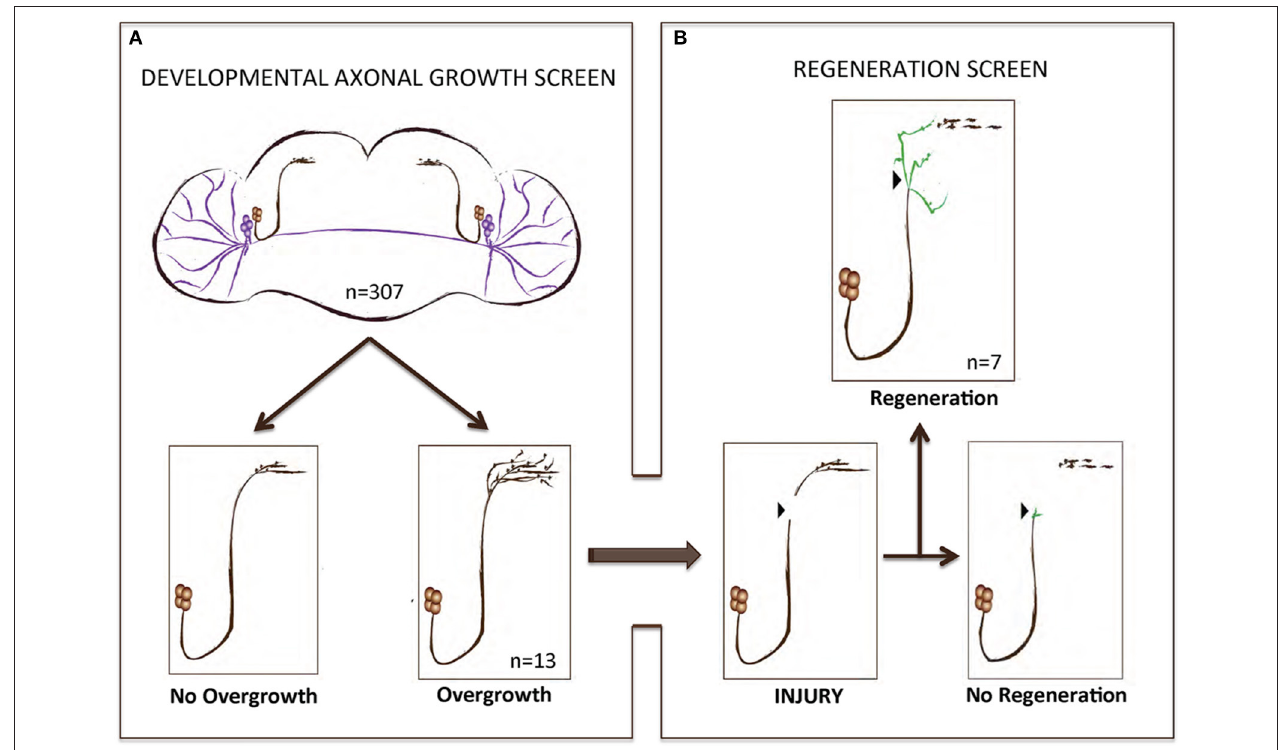
FIGURE 1 | A gain-of-function screen for axonal growth in development and after injury. (A,B) Schematic illustrating the various outcomes for the development and injury steps of the screen. Both sLNVs (dark brown) and lLNVs (purple) are depicted in (A). Gain-of-function the candidate genes specifically in PDF neurons appeared to increase growth in 4.2% ( n = 13) of the cases. Genes that stimulated axonal growth were tested further in an injury paradigm in which the sLNV axonal projection is physically cut and sLNVs were accessed for regrowth 4 days post-injury (B). Seven genes retained the ability to promote significant regeneration of injured